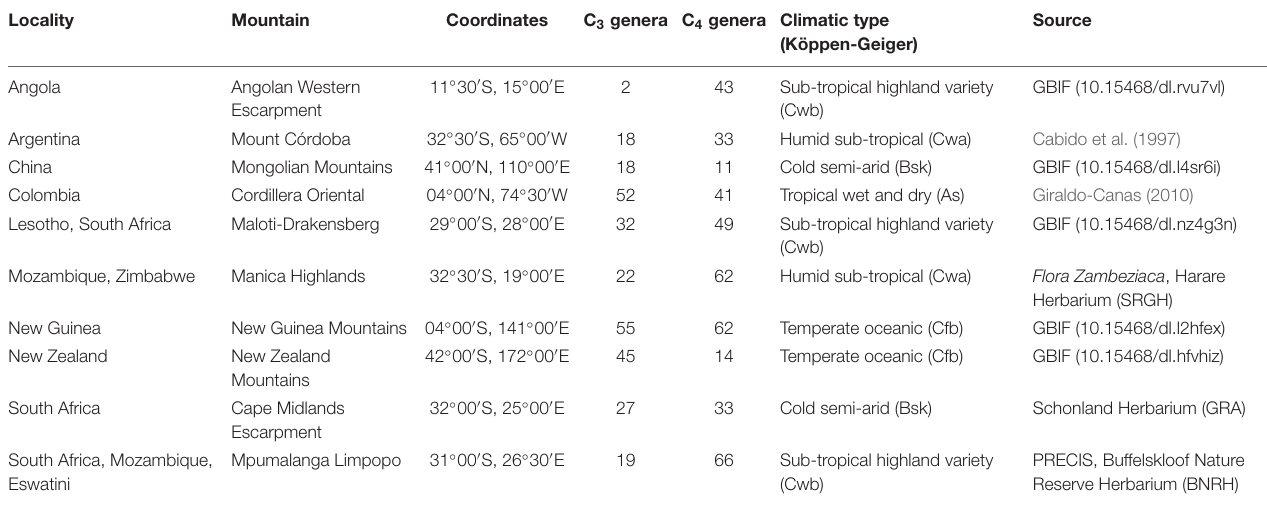
TABLE 1 | Mountain grasslands and the countries in which they occur, coordinates, number of C 3 and C 4 genera, climatic type (Köppen-Geiger), and the literature source for the species lists and occurrences.